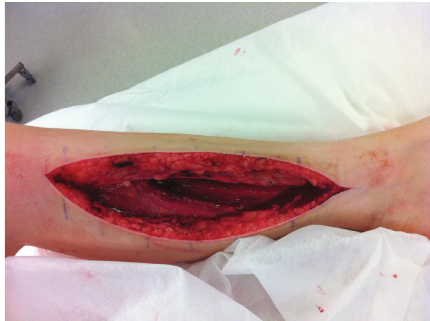
Figure 1: Medial fasciotomy of left lower leg.